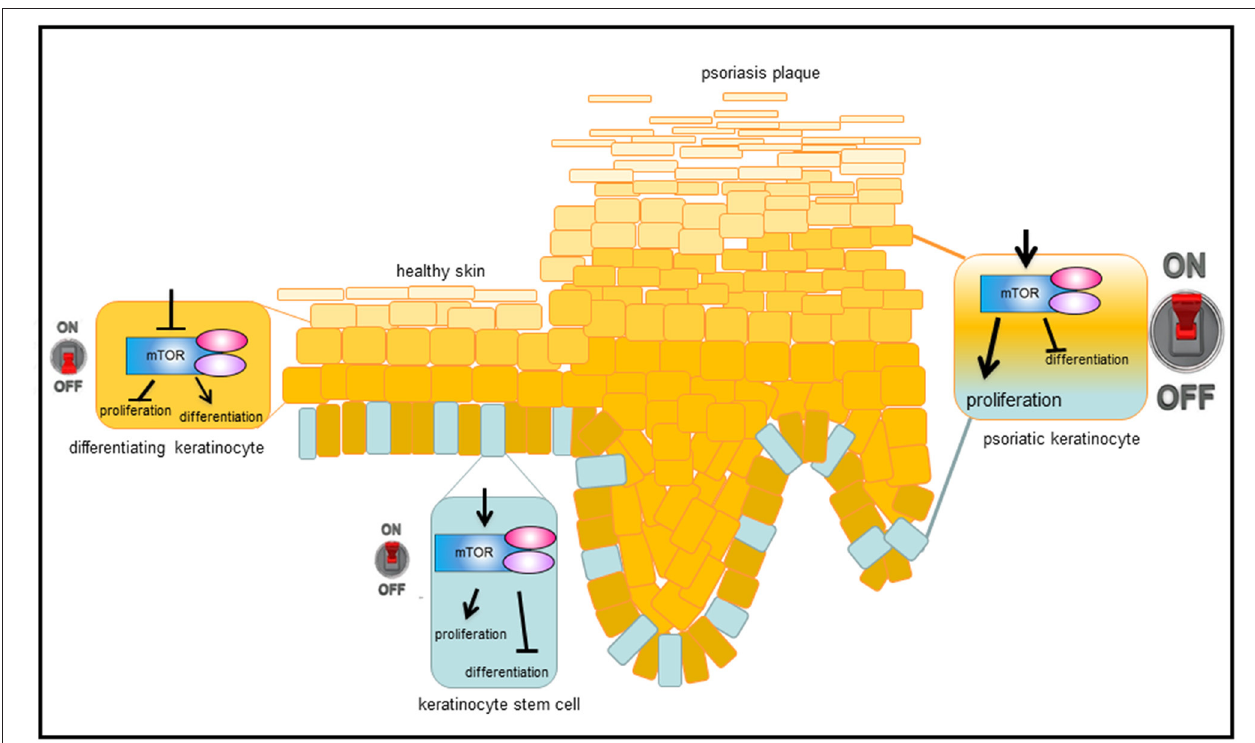
FIGURE 2 | Model, how mTORC1 signaling controls epidermal homeostasis and contributes to psoriasis. In healthy, basal keratinocytes, mTORC1 signaling pathway is active and controls proliferation while blocking differentiation. When cells leave the proliferative, basal compartment, mTORC1 is switched off and differentiation is enabled. Under inflammatory conditions, such as in psoriasis, mTORC1 is permanently activated, which leads to massive proliferation in the basal layer and disturbed keratinocyte differentiation in suprabasal layers, resulting in the phenotypic changes typical of